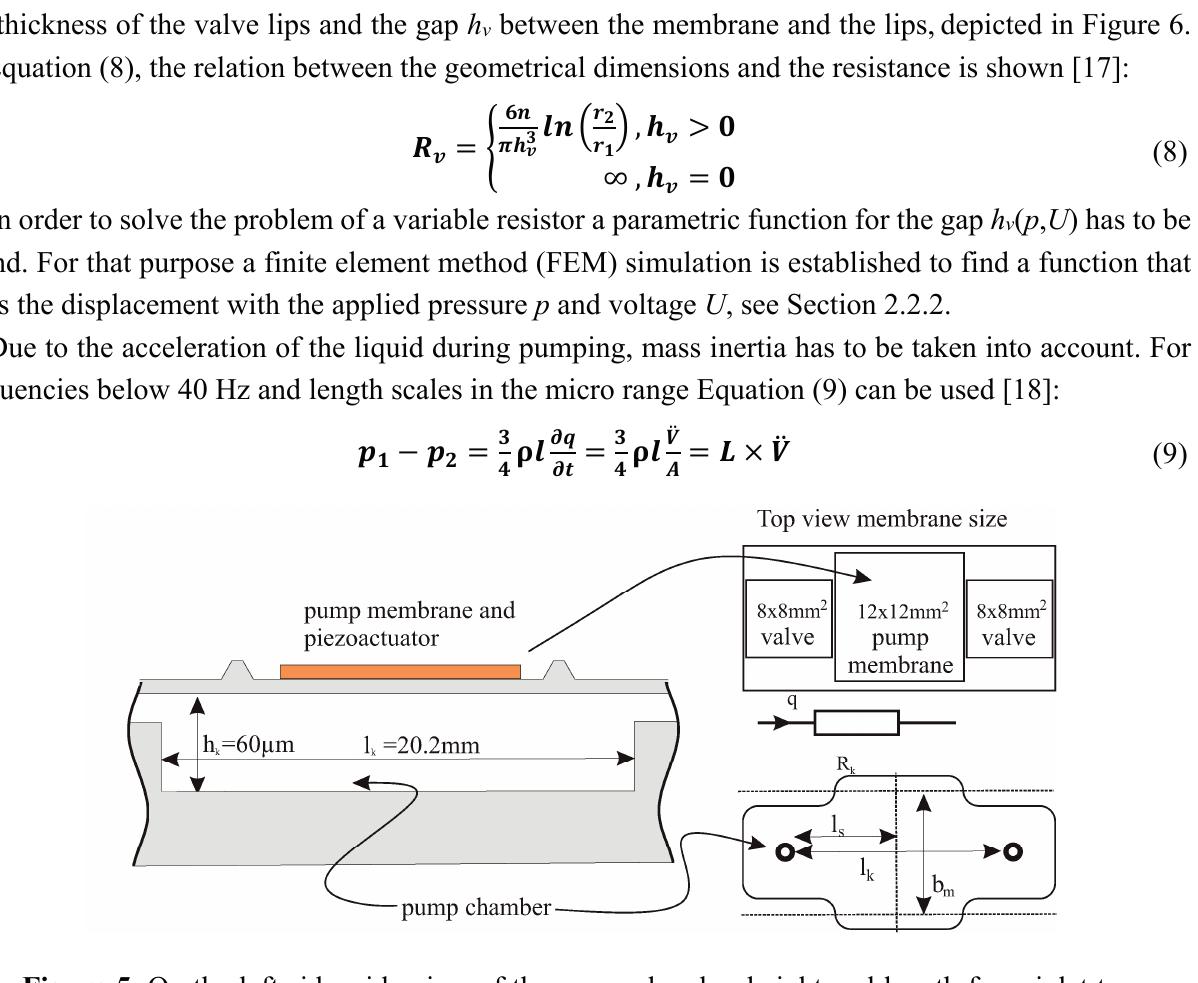
Figure 5. On the left side: side view of the pump chamber height and length from inlet to outlet. On the right side the top view of the pump chamber can be seen. The geometrical dimensions for the lumped parameter are l k , h k and b m .